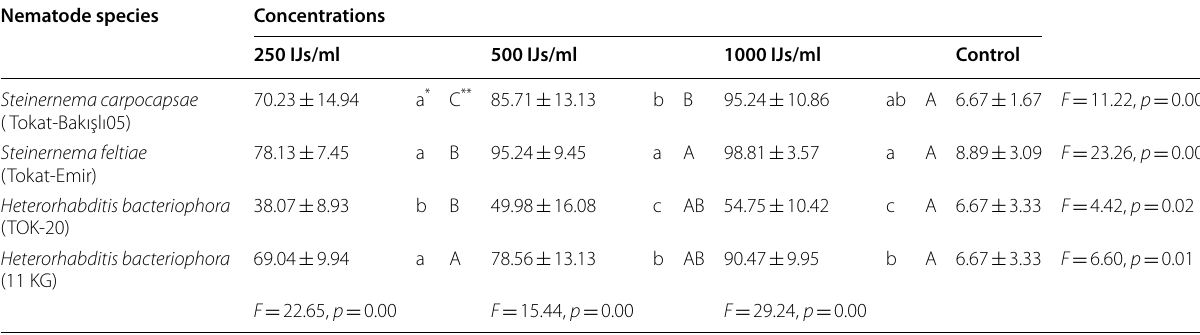
* Means within column bearing the same letter are not significantly different (Duncan’s test, p > 0.05) ** Means within lines bearing the same letter are not significantly different (Duncan’s test, p >